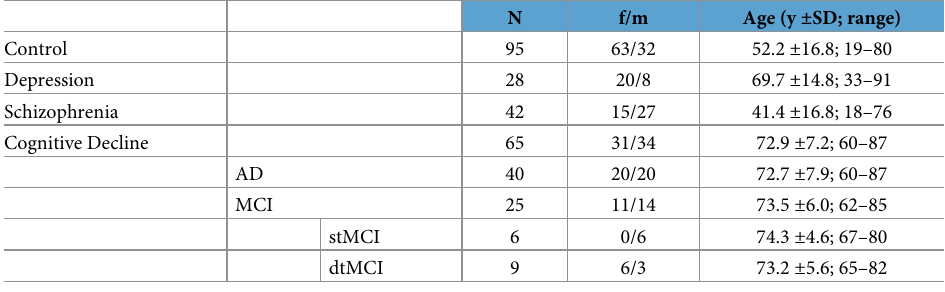
Table 1. Participants’